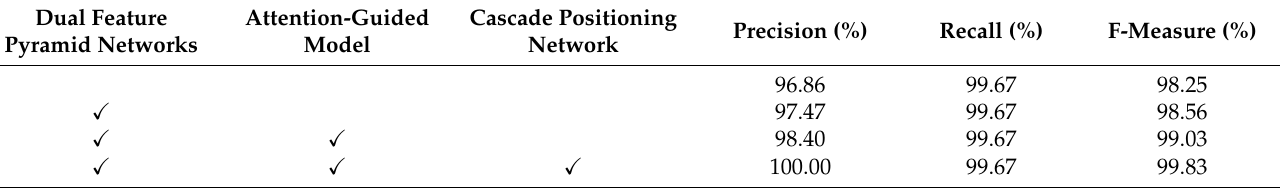
Table 2. Ablation study on AOLP.